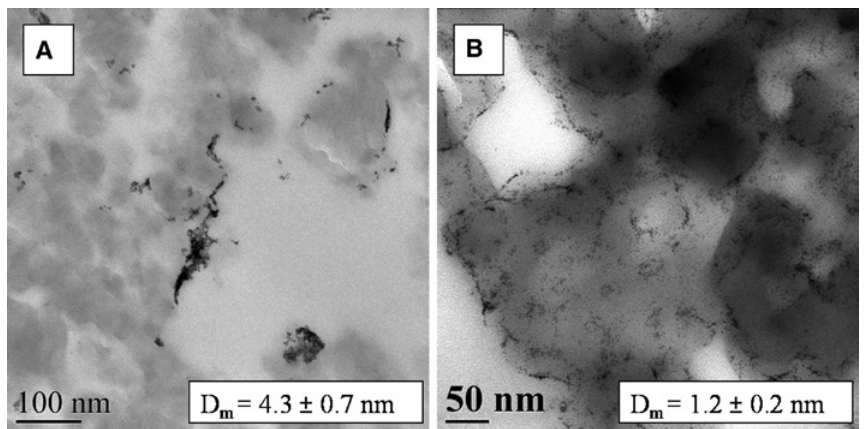
Figure 3: Transmission electron microscopy (TEM) images of (A) 3%-Ru/MN270 and (B) 3%-Ru/MN100.